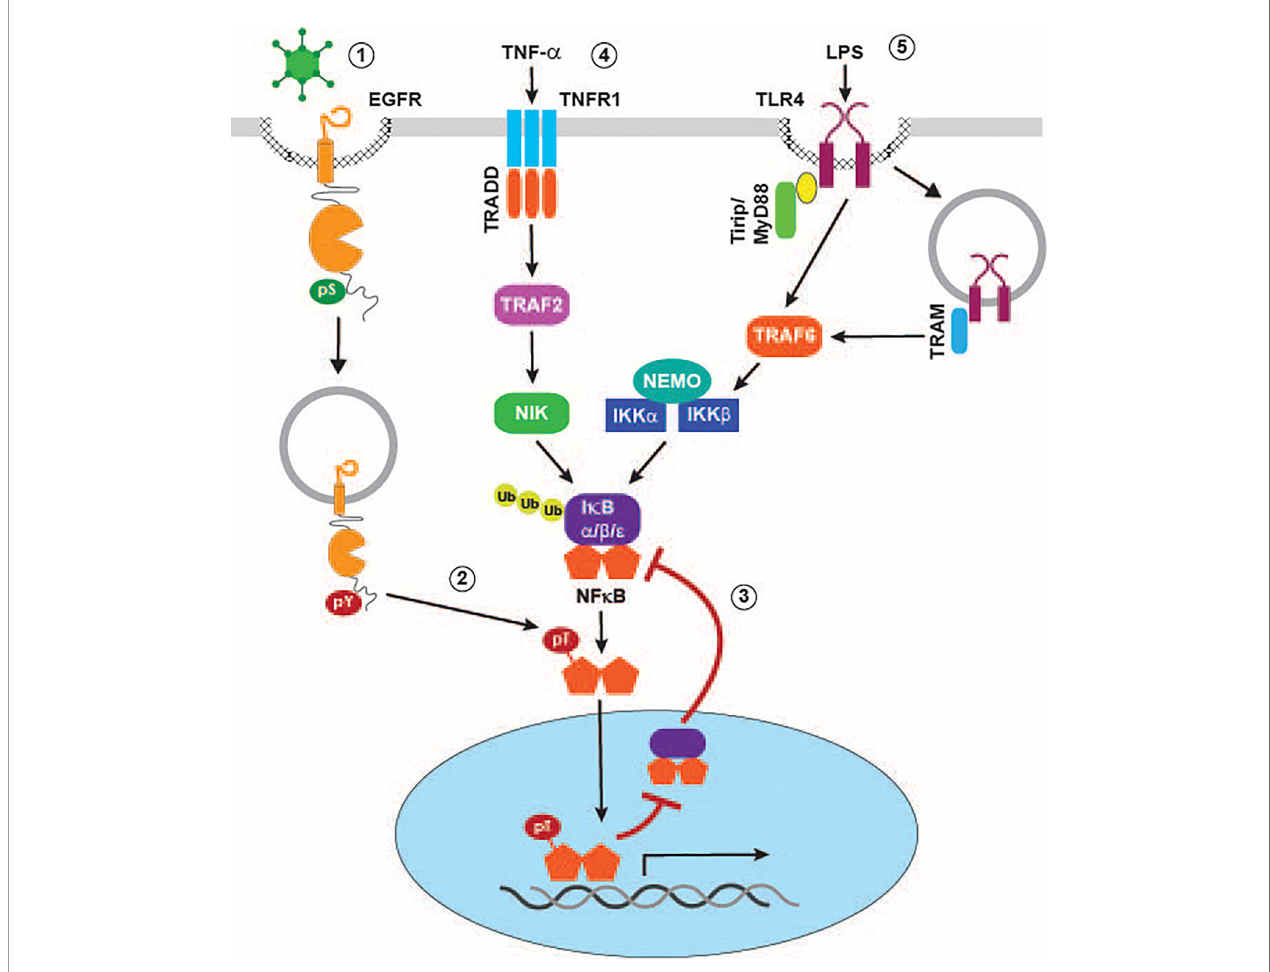
FIGURE 3 | Signaling crosstalk regulating pro-in fl ammatory NF- k B responses in virally infected cells. p38-MAPK activating viruses such as HAdV induce EGFR internalization to a non-degradative MVB subpopulation where receptors are subsequently activated independent of ligand binding (1). Stress-activated EGFRs mediate phosphorylation of the p65 NF- k B subunit at a Thr-Pro site (2), leading to inhibition of feedback control that is normally facilitated by formation of NF- k B/ I k B a complexes in the nucleus (3). TNF- a (4) and LPS (5) activate canonical NF- k B signaling pathways by mechanisms described in the